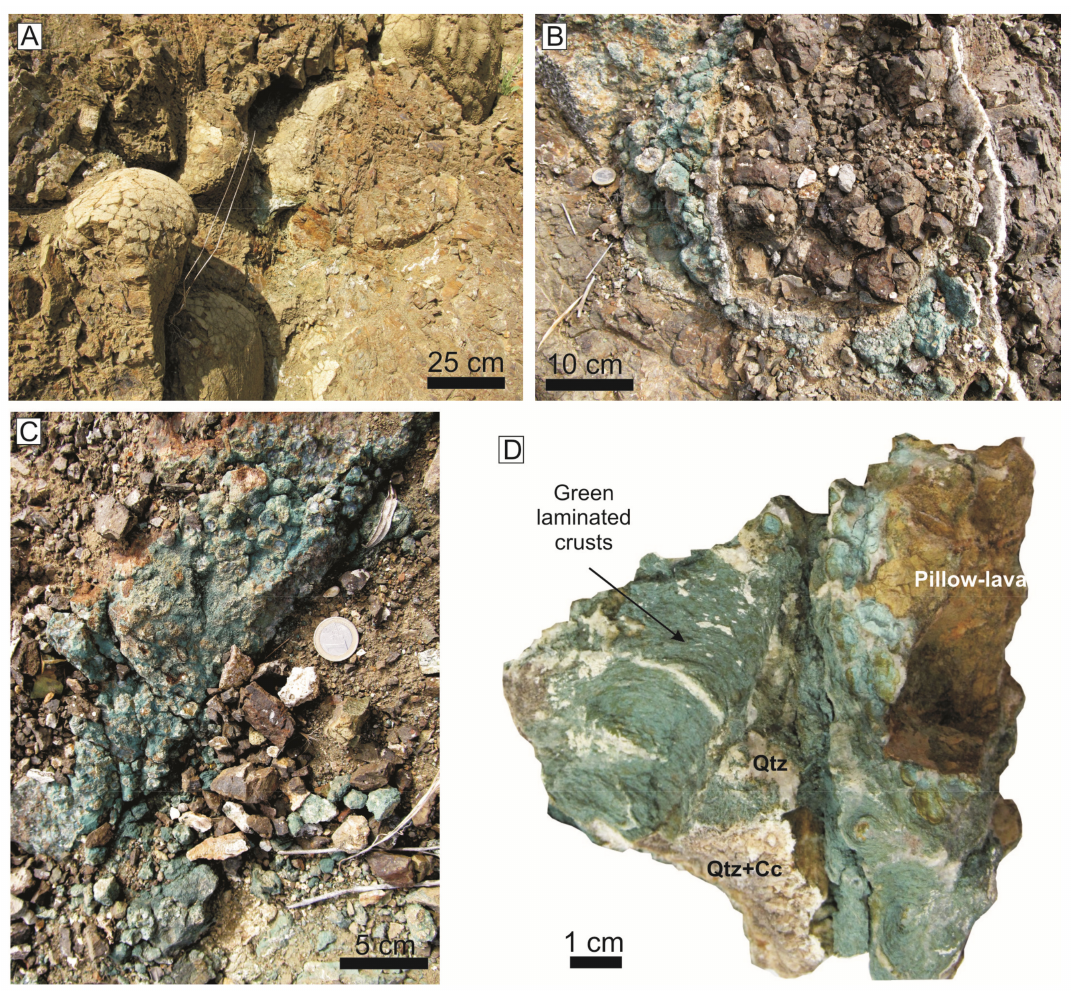
Figure 17. Jurassic pillow-lava of the Median Subbetic ( A ) and green crusts occupying the spaces between pillow-lava bodies ( B ). Note the mammillated appearance of the green crusts ( C ) favored by the presence of green laminated columns ( D ). Cc: calcite, Qtz: